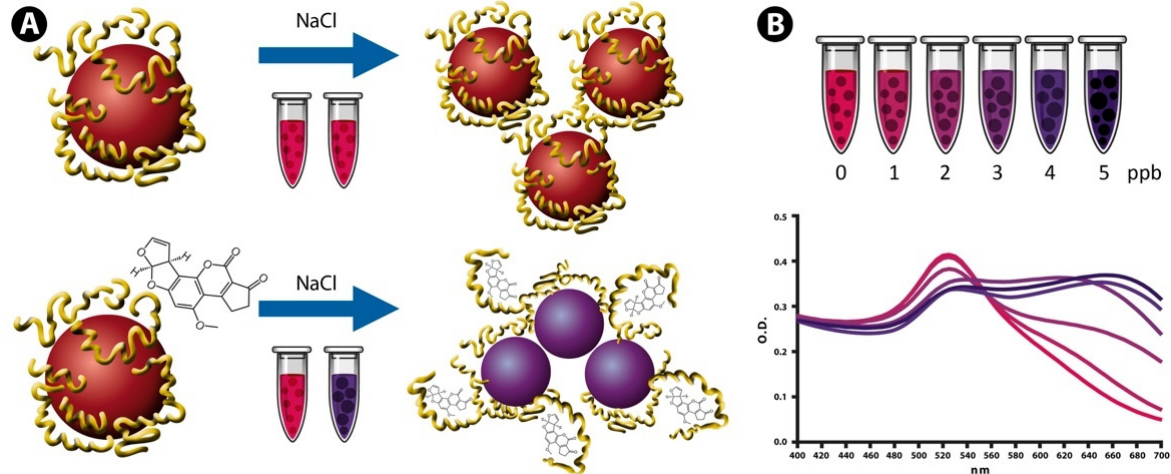
Figure 1. Schematic illustration showing the sensing principle of aptamer-conjugated AuNPs for colorimetric detection of AFB1 present in feed. ( A ) Covalently conjugated aptamers in a randomly coiled linear structure inhibit salt-induced aggregation, while the conformational change induced by AFB1 interaction decreases surface protection and allows AuNP aggregation upon NaCl addition. ( B ) Absorption spectra of the AuNPs showing antibiotic-induced aggregation of the nanoparticles and the resulting shift in the plasmon resonance peak (from red to blue-purple).